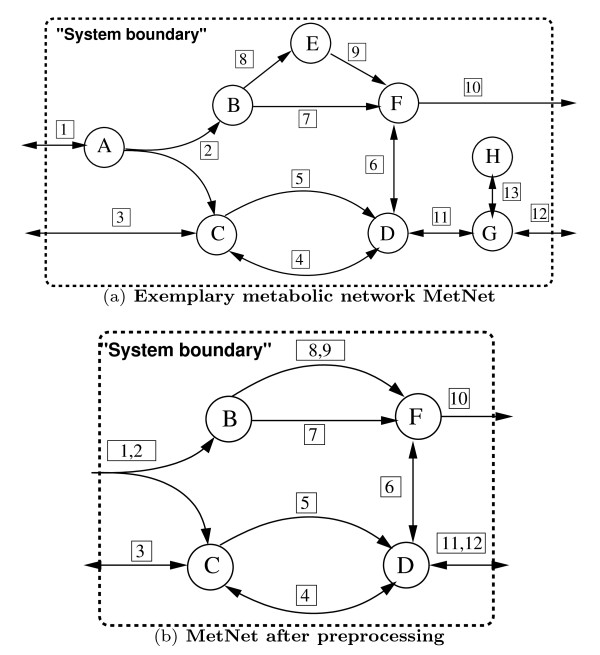
Exemplary metabolic network MetNet before and after preprocessing. (a) MetNet consists of eight metabolites (A,…,H), and thirteen reactions (1,…,13), whereof six reactions are irreversible. Metabolites are depicted as nodes while reactions are depicted as arrows. Reversible reactions are indicated by double arrowheads. (b) MetNet after preprocessing where dead-end metabolites and blocked reactions were removed and fully coupled reactions were merged iteratively. This resulted in the removal of the blocked reaction 13 and the merging of the pairs of equivalent reactions (1,2), (8,9) and (11,12)).